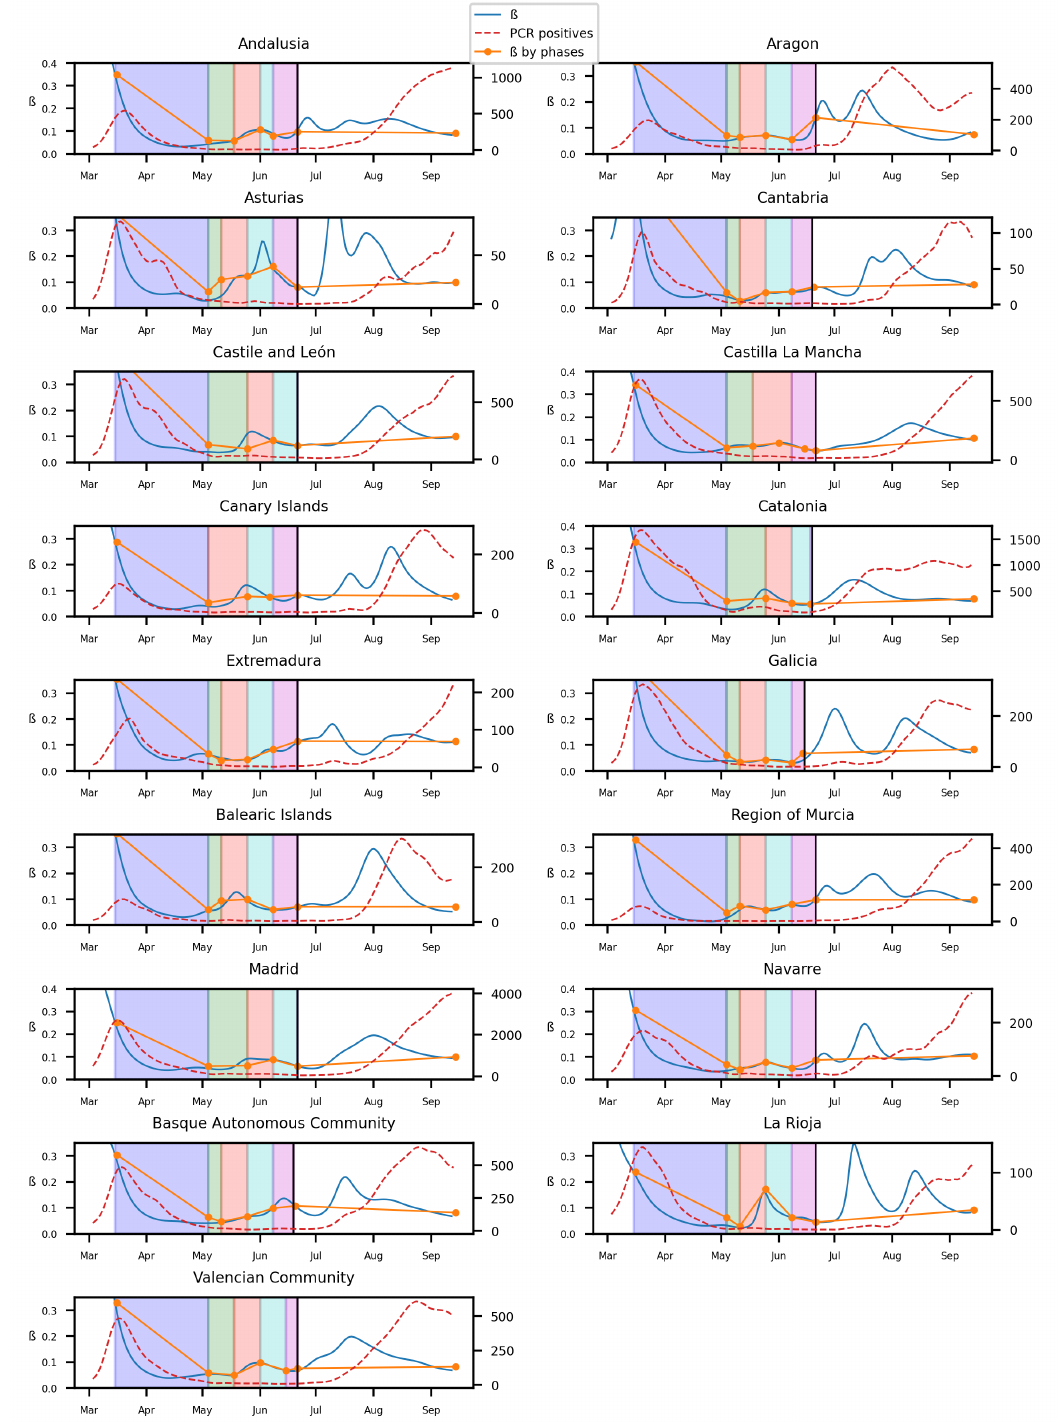
Figure 8. The y axis on the left on each subfigure correspond to β , while the one on the right to the number of new infected. Each background color represents a different stage of lockdown of Spain: Lockdown, phase 0,1,2,3. White background correspond to pre-lockdown and normality . Red dotted line: The value of new infected individuals at that day. Blue thin line: A 15-days average of β at that day calculated from Equation (10). Orange thick line: A linear regression of β during each